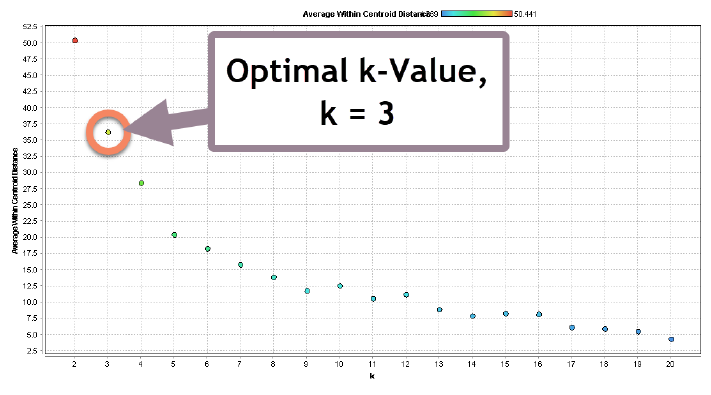
Fig. 6. The appropriate number of clusters of course 7011303 (2020) Table 5. Average within centroid distance (ACD) results for course 7011303 (2020)